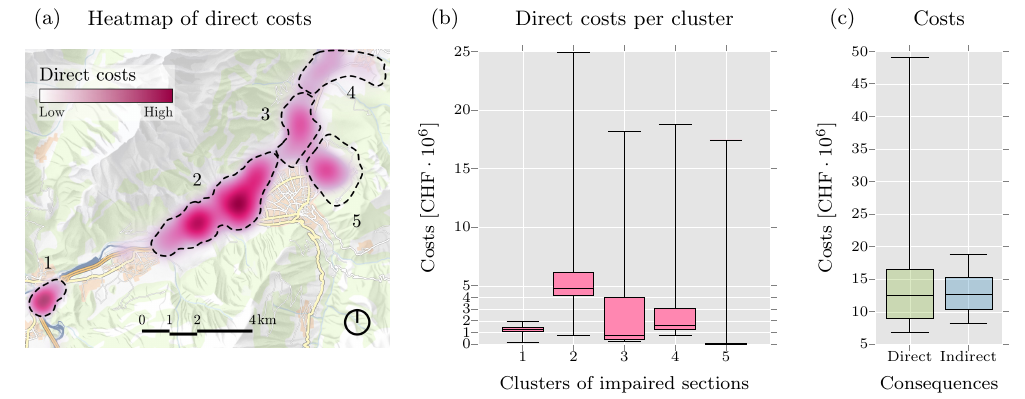
Figure 9. Direct and indirect costs related to the hazard events with 500 year return period. A heat map of expected direct costs for all sce- narios (a) can be used to analyze high-risk areas. Here, five clusters were detected. The estimated direct costs per cluster and their associated uncertainties are illustrated in panel (b) using box plots. While in the second cluster, the median direct cost was around CHF4.8million, in the fifth cluster, a much smaller median value was estimated. However, the uncertainty of this cluster on the positive direction was compara- ble to that of the second cluster in the same direction. Comparing direct and indirect costs (c) , their medians were similar. Nonetheless, the distribution of direct costs was positively skewed (heavy tail) while the distribution of indirect costs was close to